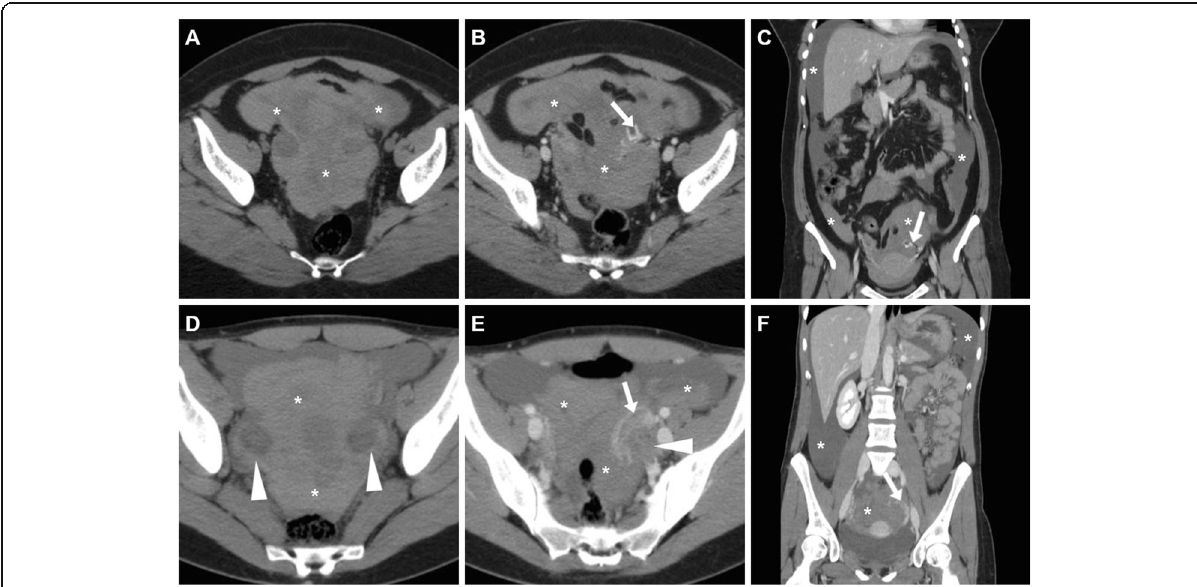
Fig. 16 Two surgically proven cases of haemoperitoneum from early extrauterine pregnancy. a – c Unenhanced ( a ) and postcontrast ( b , c ) CT images show diffuse hyperattenuating peritoneal effusion (asterisk), enlarged left ovary containing a focal contrast extravasation (arrows in b and c ) indicating active bleeding. d – f Unenhanced ( d ) and postcontrast ( e , f ) CT images show haemoperitoneum (asterisk), bilateral cystic-like ovarian lesions (arrowheads) with active haemorrhage on the left side (arrows in e and f